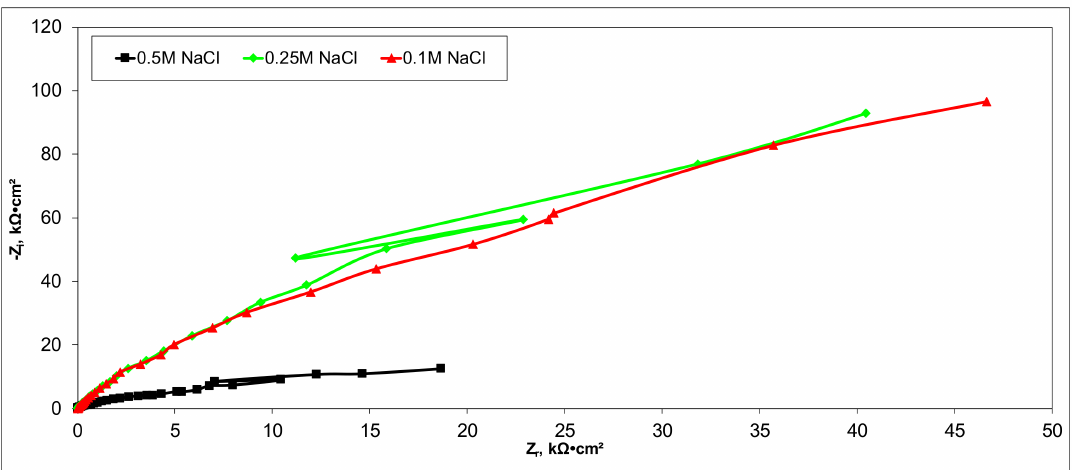
Figure 14. Nyquist plots for the X3 variant in NaCl: 0.5M, 0.25M, 0.1M.